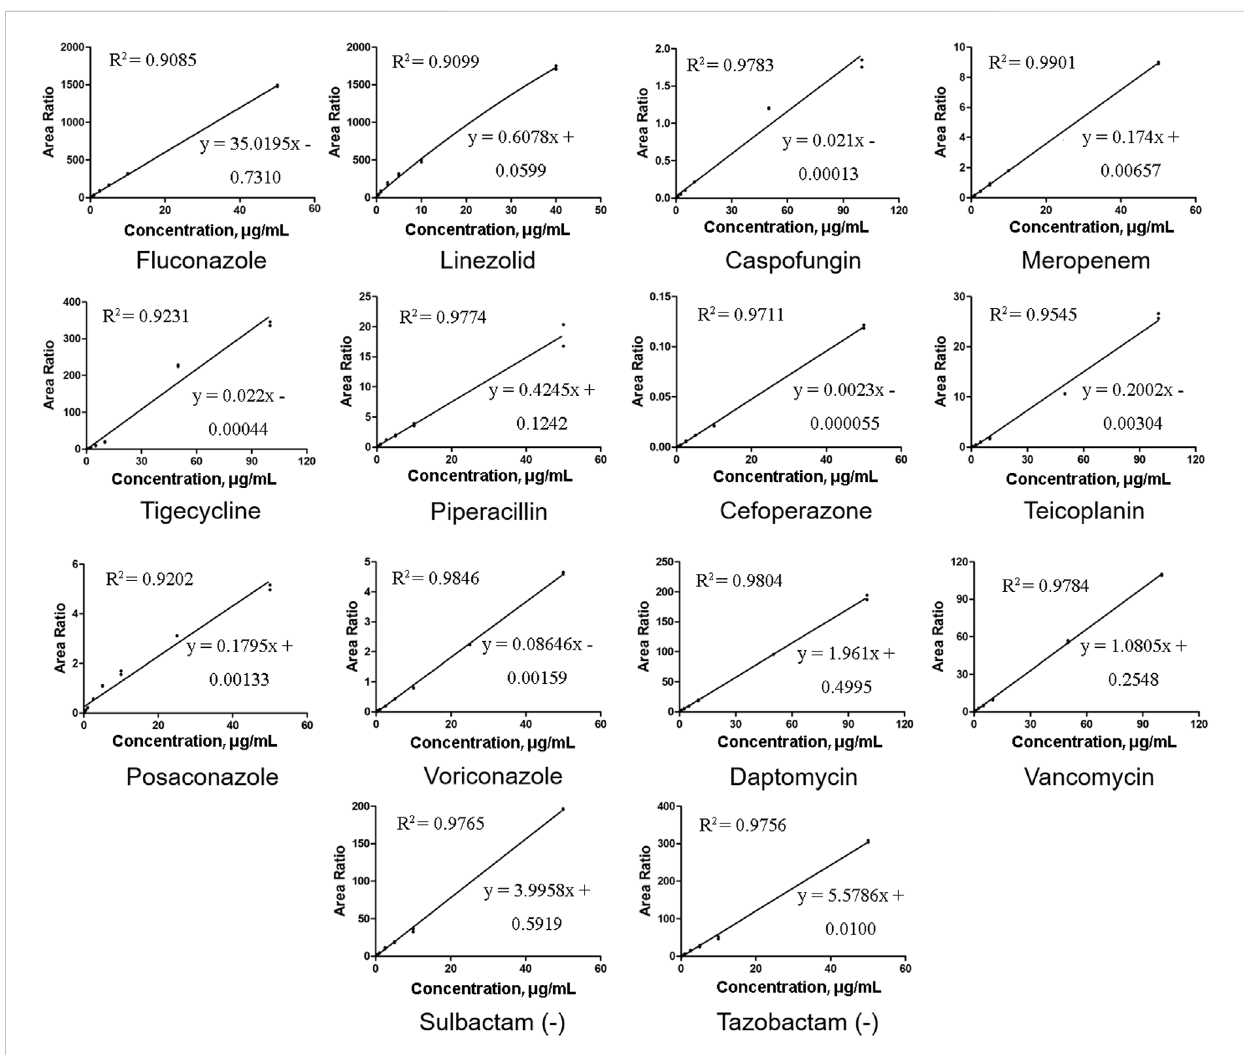
FIGURE 2 Representative calibration curves of 14 antibacterial agents. All the correlation coef fi cient ( R 2 ) values were at least 0.9085 or higher.